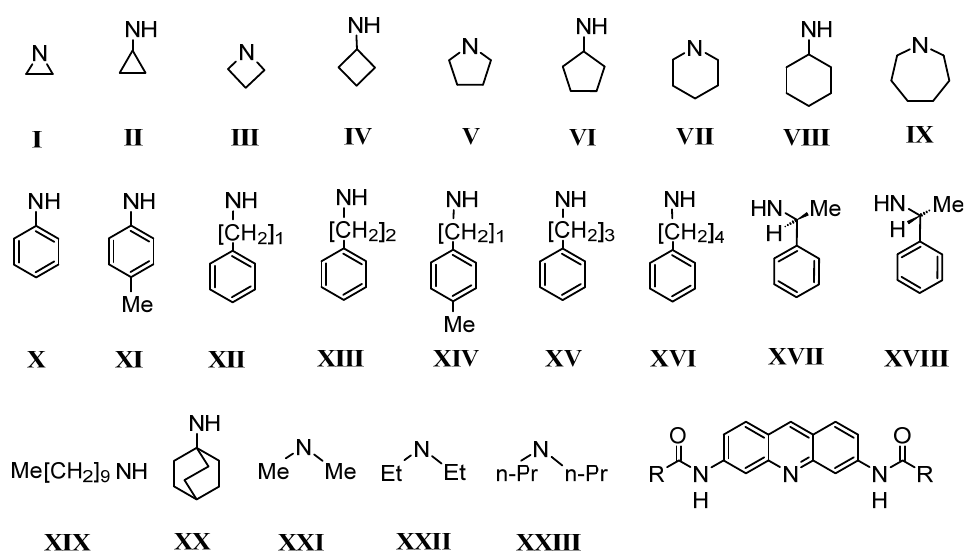
Figure 5. Urea models I–XXIII used within the molecular modeling study. Table 2. Physicochemical data for urea models I–XXIII.